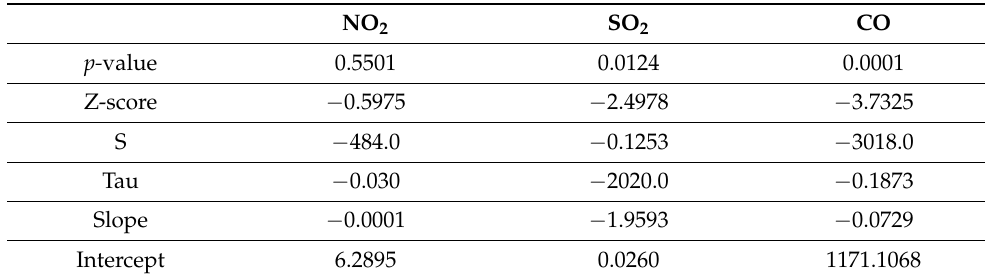
Table 1. A summary of the Mann-Kendall test statistics for the de-seasonalized timeseries of NO 2 , SO 2 and CO at 95% confidence